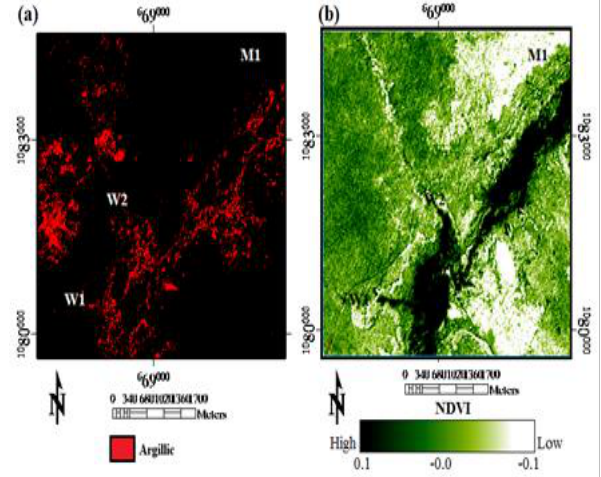
Figure 3 . Results of SAM at Wikki ROI using library spectra showing alteration zones. (a) 0.10 default radian angle (b) NDVI image at Wikki ROI showing vegetated-exposed zones The accuracy assessment for the SAM result using library spectra is shown in table 5 which indicates an overall accuracy of 100% and Kappa of 1.00 respectively.